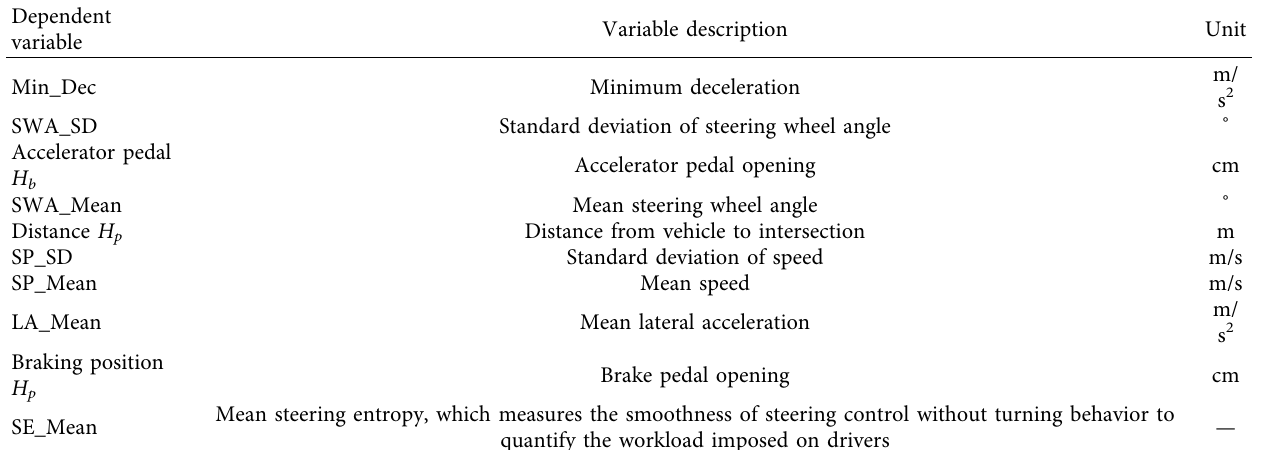
Table 2: Driving performance-related features.